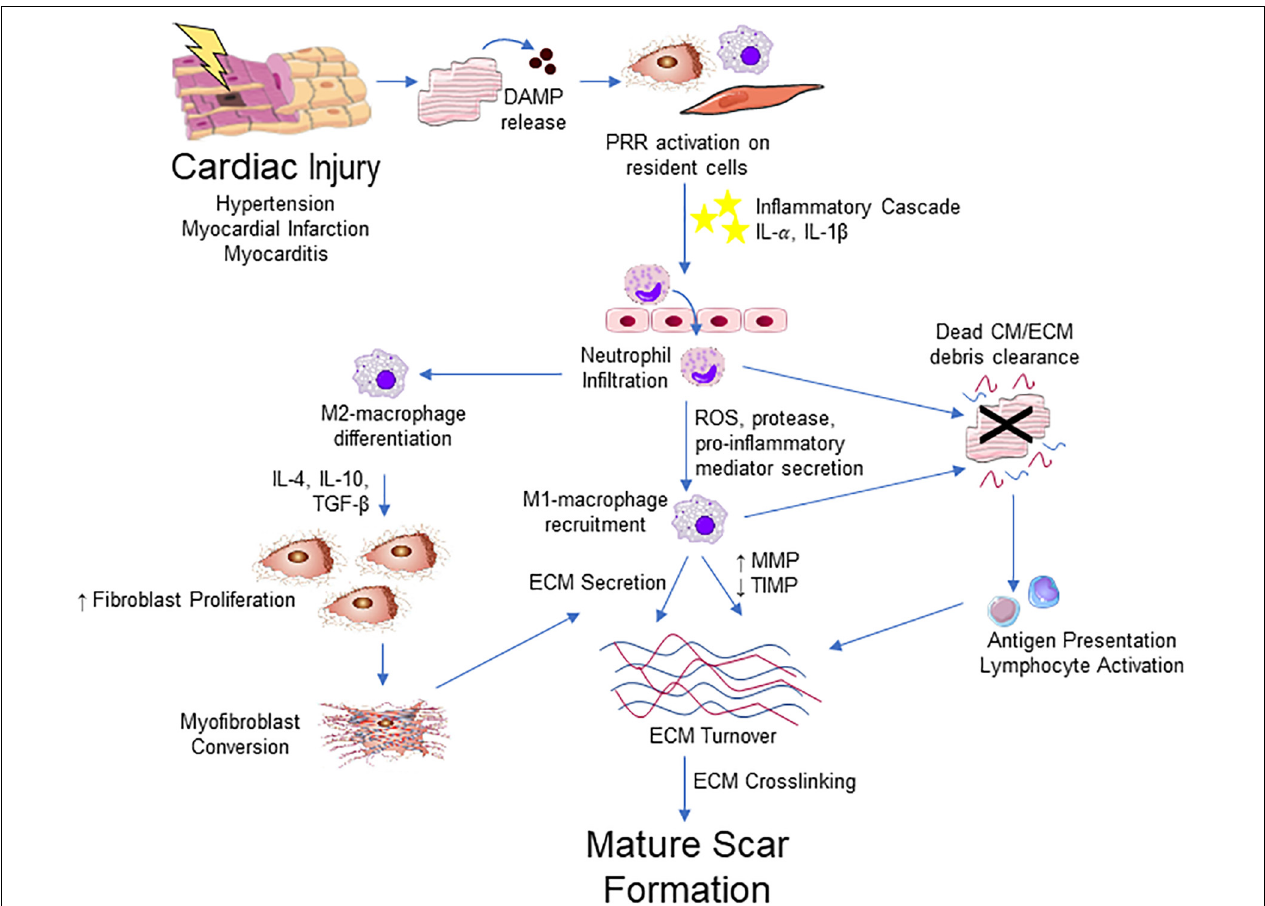
FIGURE 4 | Integrative schematic of inflammation and cardiac fibrosis. After a cardiac insult, the release of DAMPs from dying or damaged cardiomyocytes (CM) triggers an inflammatory cascade through PRRs expressed on resident fibroblast, endothelial, mast cell, macrophage and other immune cell populations in the heart. This results in the cytokine/chemokine-mediated infiltration of the immune cells, initially neutrophils then Ly-6C high monocytes that contribute to an increase in M1-like macrophages into the myocardium. M1-like macrophages and neutrophils contribute to clearance of dead cells and ECM debris through phagocytosis. Macrophages also contribute to ECM remodeling through the production of collagen and other ECM components and ECM turnover though the regulation of MMPs and TIMPs. Macrophage engulfment of apoptotic neutrophils promotes and M2-like phenotype, which promotes the proliferation and migration of fibroblast and promotes differentiation into myofibroblast, primarily through the action of TGF- β . Antigen presentation by phagocytic cells activate T lymphocyte populations that contribute to fibrosis through poorly defined mechanisms. Myofibroblasts are the major source of ECM components and contribute to remodeling of the ECM. The fibrotic response concludes with ECM crosslinking and the apoptosis or quiescence of immune cells and myofibroblasts, producing a mature scar.